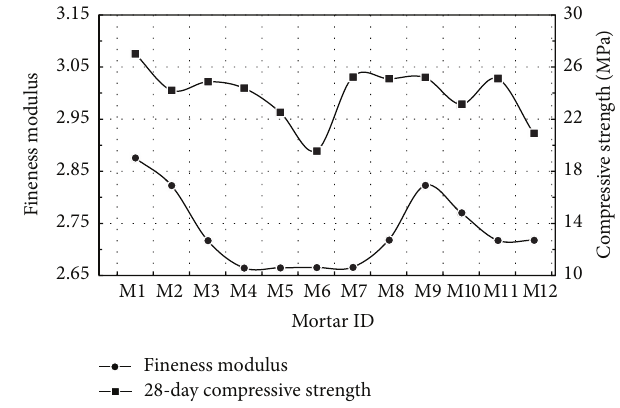
Figure 8: 28-day compressive strength for different mortar mix proportion and the effect of fineness